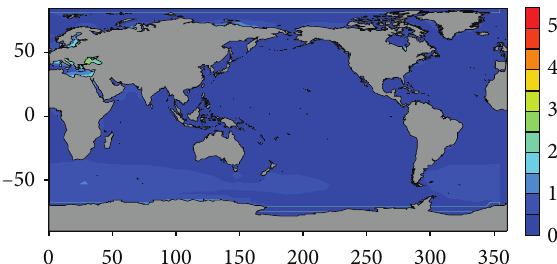
Figure 11: The spatial distribution of RMSE of sea surface tempera- ture using